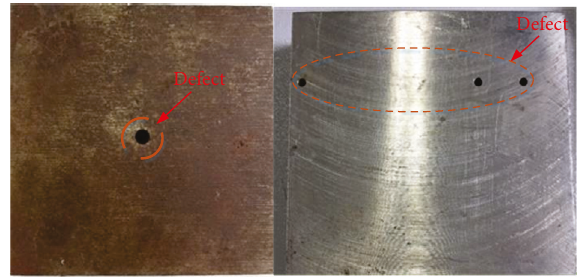
Figure 9: The specimen 1 and specimen